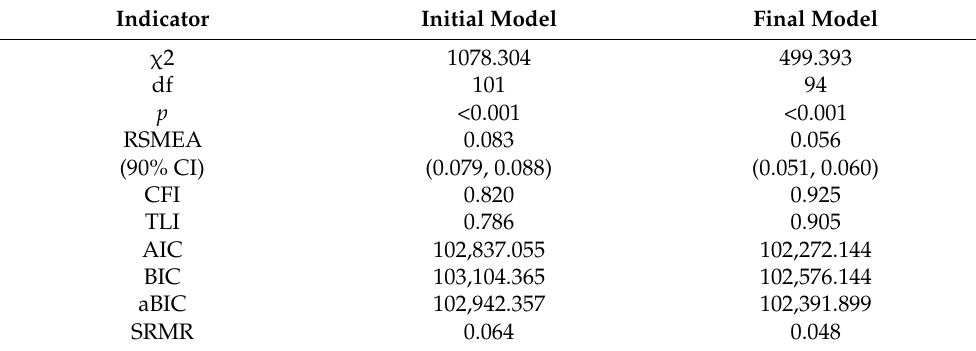
Table 2. Comparison of the goodness of fit parameters between models of KAP questionnaire on tranquilizer